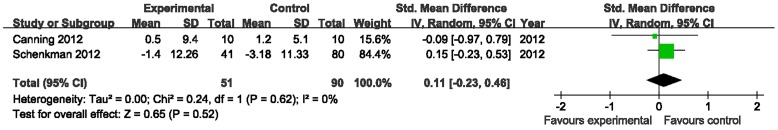
Forest plot showing the effect of aerobic exercise on quality of life in patients with Parkinson's disease.